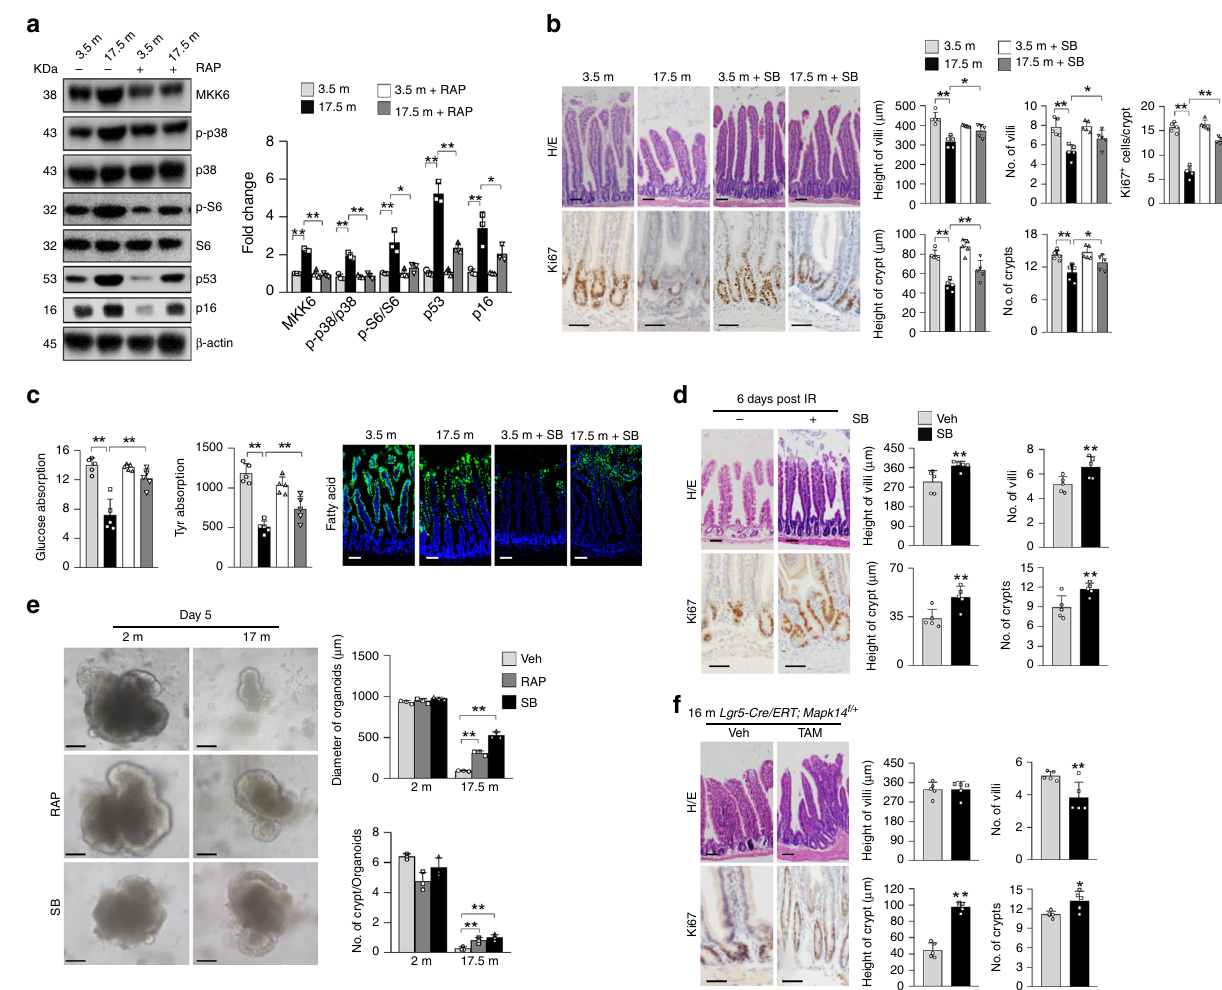
Fig. 6 Inhibition of p38 MAPK rescues natural aging of mouse villi. a Western blot results showed that 17.5-month-old mouse crypt samples displayed elevated MKK6 expression, increased p38 MAPK activation, and increased p53 and p16 levels, which were suppressed by RAP treatment for 1.5 months starting at 16 months of age. Right panel: quanti fi cation data (mean ± SEM). N = 3 mice per group. * P < 0.05, ** P < 0.01 (determined using Student ’ s t test). b – d Inhibition of p38 MAPK largely rescued the deterioration in villus and crypt structures ( b ), decreased nutrient absorption activities ( c ), and compromised regeneration ( d ) in 17.5-month-old normal mice. The mice were treated with SB203580 for 1.5 months. Data are expressed as mean ± SEM. N = 5 mice per group. * P < 0.05, ** P < 0.01 (determined using Student ’ s t test). e Representative images showing that SB203580 (2 μ M) or RAP (0.5 μ M) partially rescued the defects in growth and crypt formation of minigut organoids isolated from 17.5-month-old mice. The inhibitors were added to the culture at day 1 of the organoid cultures. Bottom panels: quanti fi cation data (mean ± SEM). N = 3 mice per group. ** P < 0.01 (determined using Student ’ s t test). f Lgr5-CreERT;Mapk14 f/ + mice (TAM injected at 2 months of age) did not show aging-like villus structural defects at 16 months of age. The intestines were sectioned and stained with H/E or Ki67 antibodies. Right panels: quanti fi cation data (mean ± SEM). N = 5 mice per group. * P < 0.05, ** P < 0.01 (determined using Student ’ s t